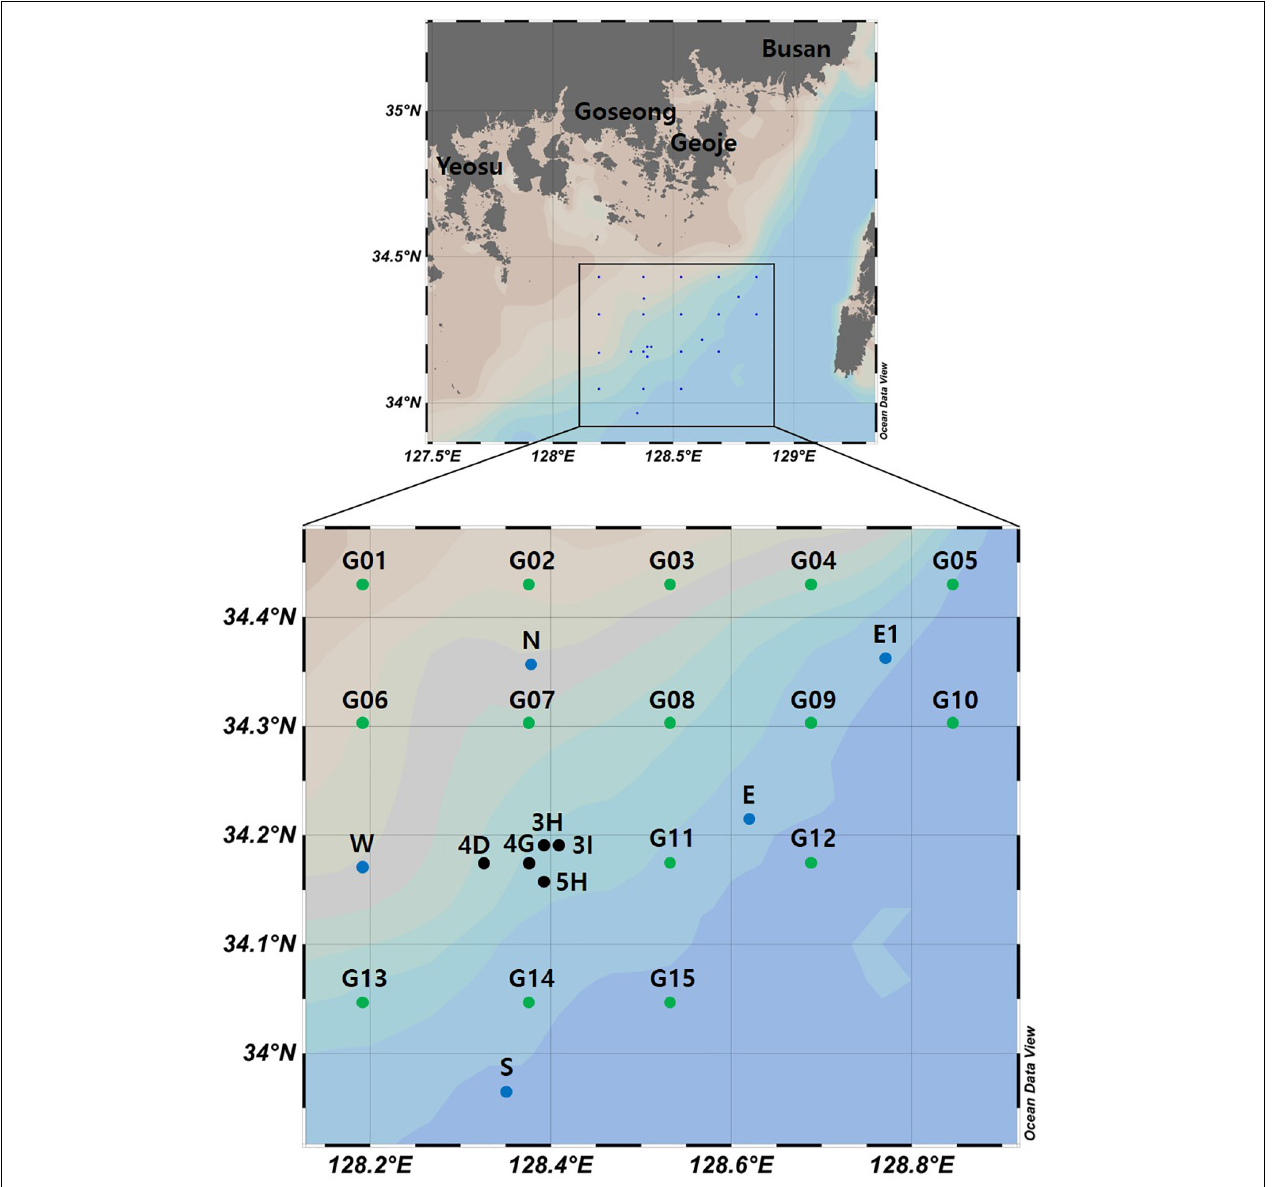
FIGURE 1 | Seawater sample collection sites for the metabarcoding analyses of fish assemblages and phytoplankton community structure from southern coastal waters of Korea (black dots represent aggregate mining sites, blue and green dots represent control sites in September and February,